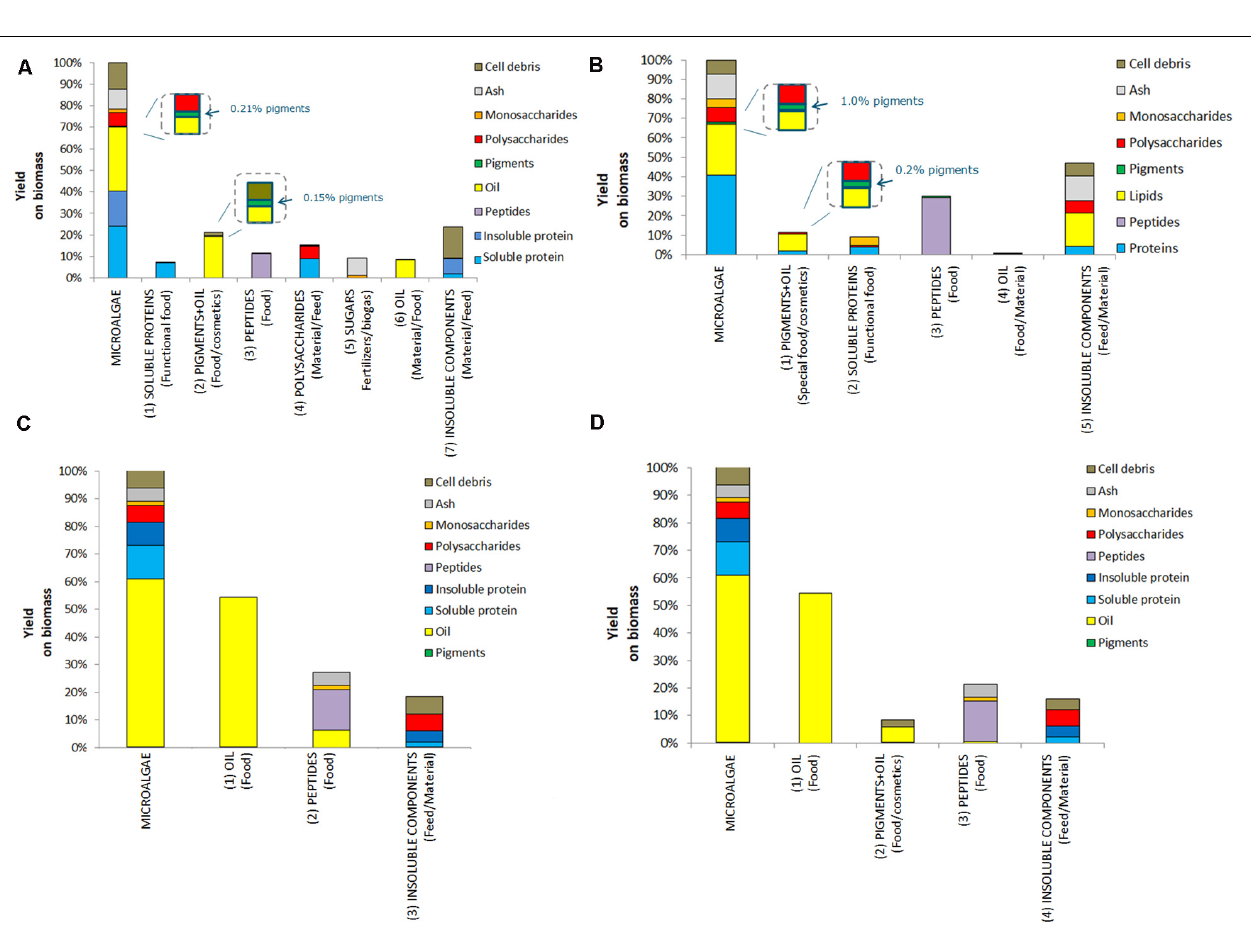
FIGURE 6 | Initial biomass composition and detailed breakdown of the composition of the product streams for multiproduct value chains (MP); (A) MP1, (B) MP2, (C) MP3, and (D)